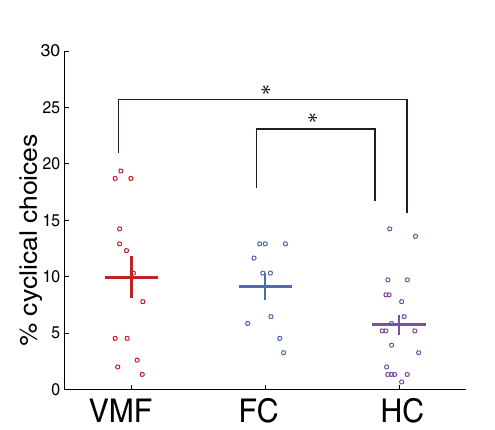
Fig. 2 | Participants with VMF damage have higher decision variability. A illustration of the drift diffusion model. After the non-decision time (part of the reaction timenot related tothe decision process),the decisionvariablebeginsata starting value and accumulates variable evidence ateach time step towards one of the two choice options, until it reaches threshold for one of them. B DDM para- meter fi ts: variability, drift rate, initial starting point, non-decision time, and alpha (exponent on rank distance). Error bars are standard errors of the mean. * denotes